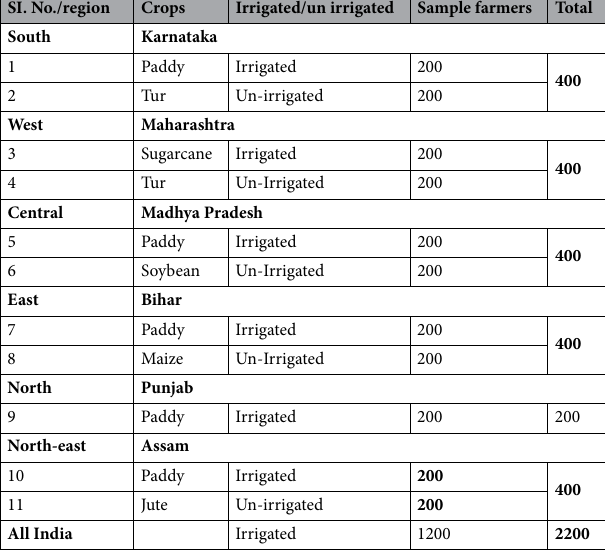
Table 1. State-wise, crop coverage and sample size. Source: Authors’ estimates using field survey